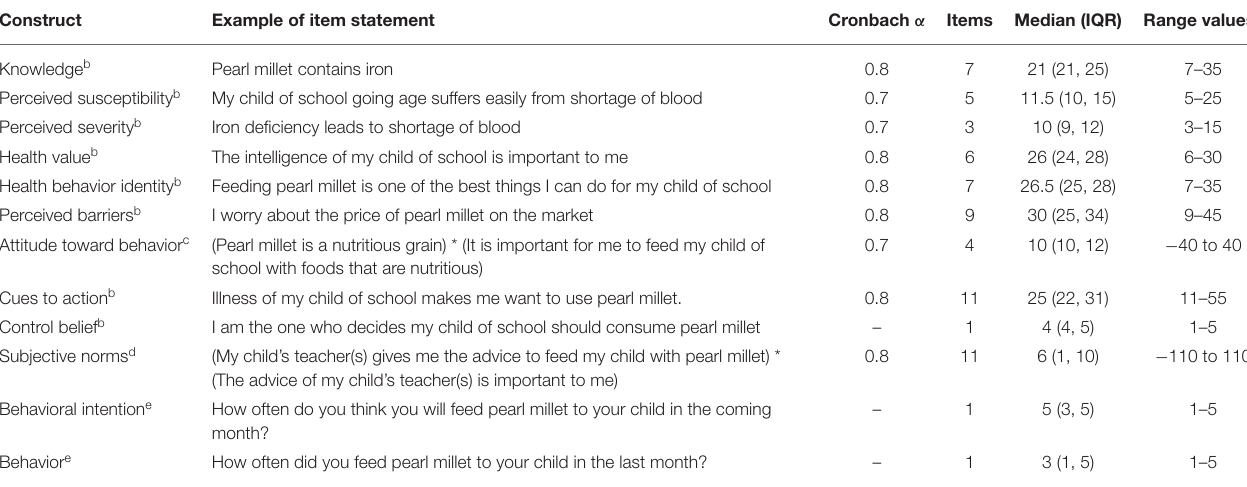
TABLE 5 | Internal consistency and median scores of the constructs.